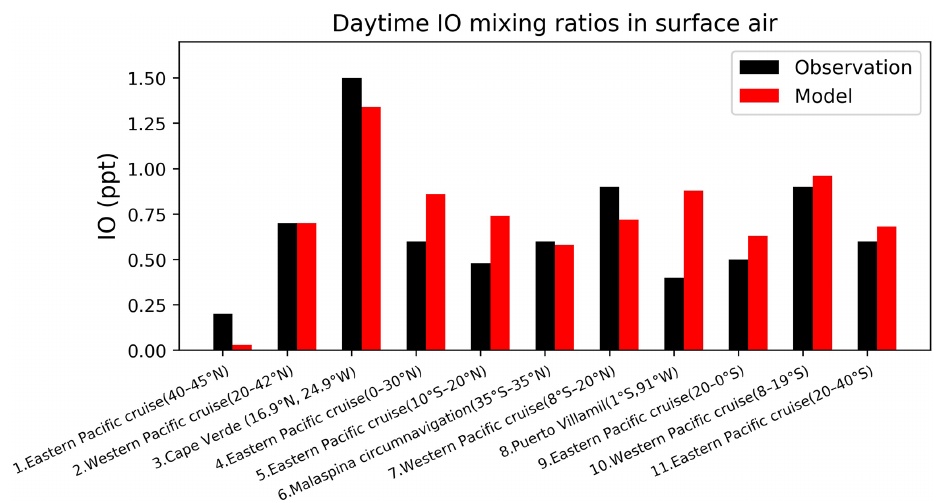
Figure 11. Daytime surface air mixing ratios of IO from island sites and ocean cruises, arranged from left to right in order of decreasing latitude. Observed values (black) are means for the reporting period in different years. Model values (red) are monthly mean values in 2016 taken for the same month and location as the observations. References: (1, 4, 9, 12) Mahajan et al. (2012), (2, 7, 10) Großmann et al. (2013),